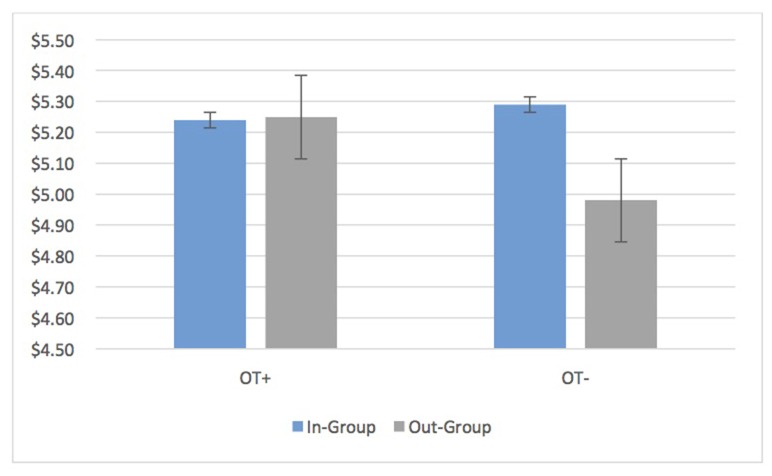
OT+ participants have identical average transfers to in-group and out-group members in the ultimatum game (UG) while OT− participants show an average bias of 6.2% ($0.31) towards in-group members. Bars are standard errors.